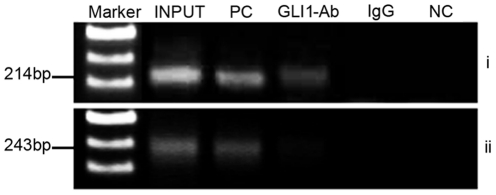
Identification of GLI1 binding to DNMT1 promoter by Chromatin Immunoprecipitation (ChIP).Lysates from PANC-1 cells were subjected to Chromatin immunoprecipitation by anti-GLI1 antibody. Sonicated chromatin was used as INPUT DNA control (INPUT). RNA polymerase II was used as positive control (PC). IgG was used as random control (IgG) and β-actin Ab was used as negative control (NC). The band of ChIP-PCR products amplified by DNMT1 Primer-C (i) and by DNMT1 Primer-B (ii) were shown.